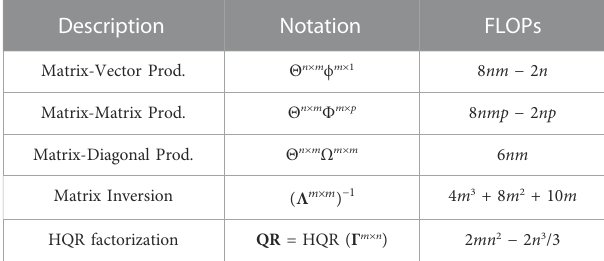
TABLE 1 Common matrix algebra computational